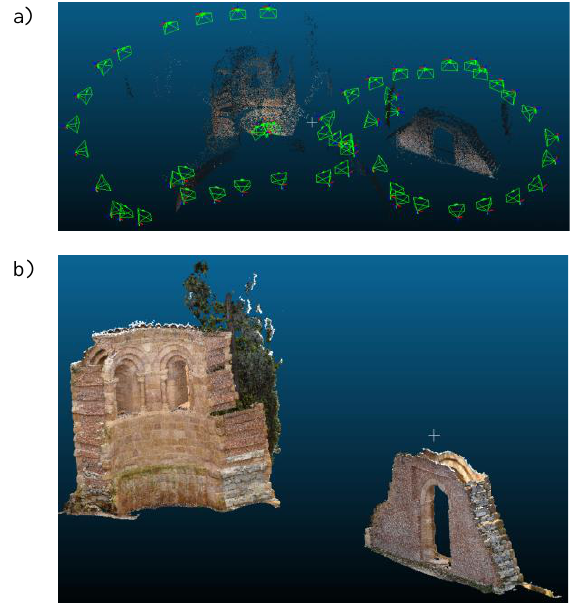
Figure 5. Results obtained during the photogrammetric reconstruction: a) sparse point cloud of the façade and; b) dense point cloud of the façade.